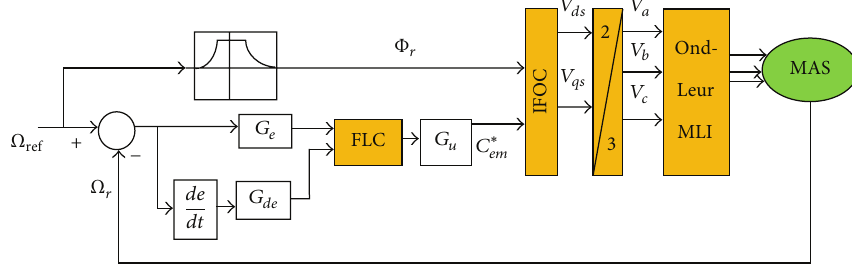
Figure 1: The overall structure of a fuzzy controller.